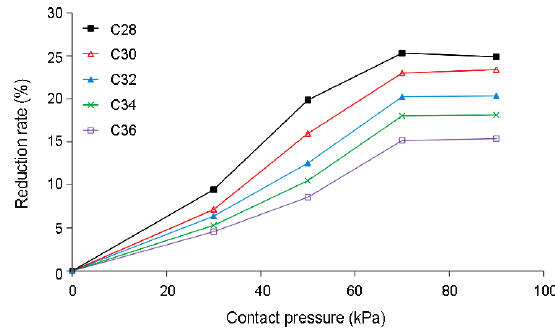
Fig. 14. Variation in oil film as a function of contact pressure for